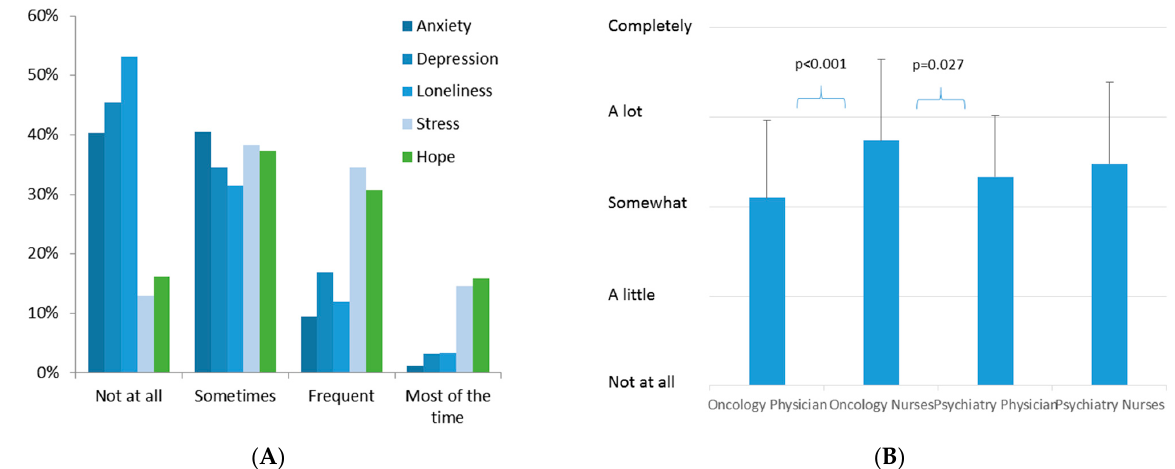
Figure 3. ( A ) Histograms of personal conditions for professionals. ( B ) Burden due to decisional con-